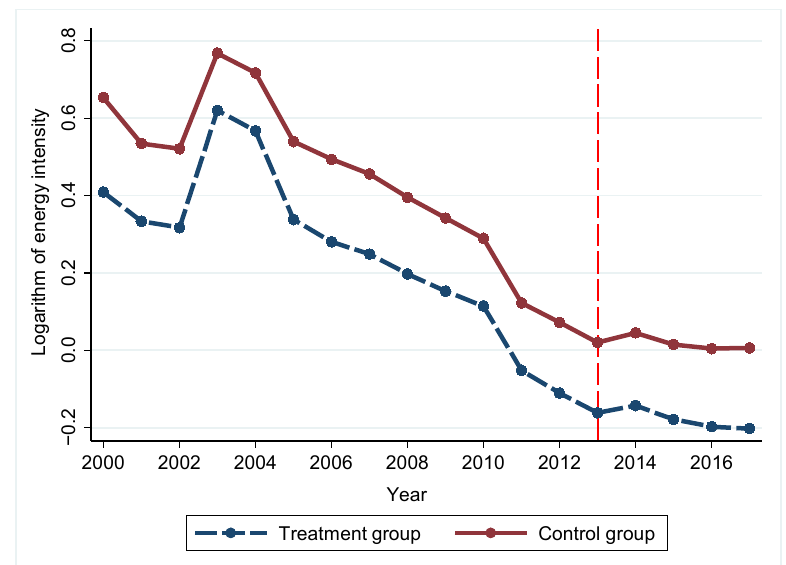
Figure 3. Parallel trend test.